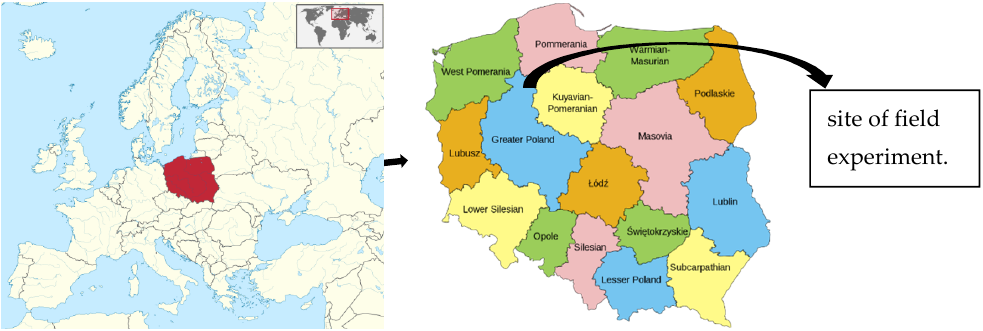
Figure 1. Site of field-scale experiment at Śmielin, Kuyavian-Pomeranian voivodeship, Poland [28,29].